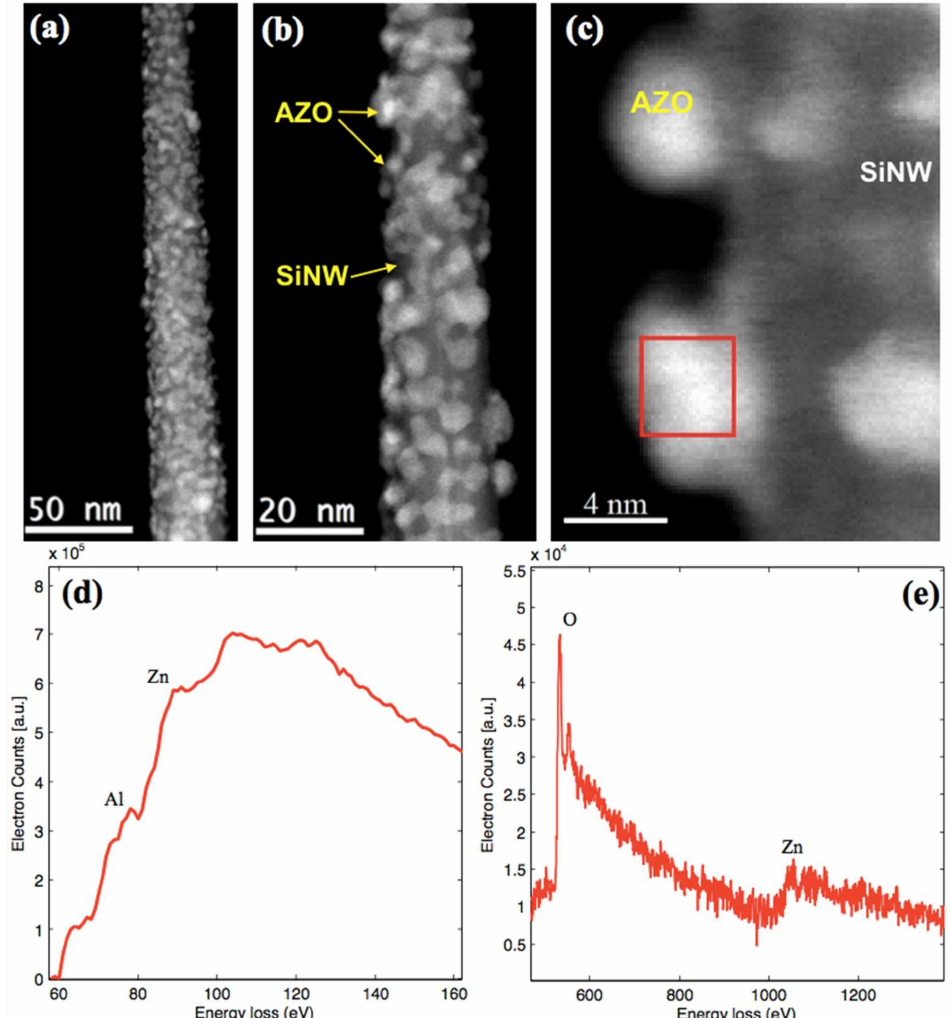
Figure 2. ( a – c ) STEM images at different magnifications for the SiNW/AZO system. The equivalent thickness of the deposited AZO layer is 2 nm; the diameter of the Si-NW imaged is about 20 nm. The AZO clusters diameter is smaller than 10 nm. ( d , e ) EELS spectra extracted from significant region as shown by the red rectangle in ( c